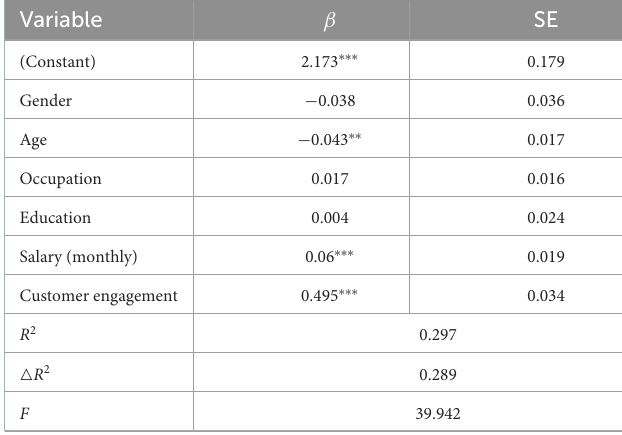
TABLE 7 Hierarchy regression results of control variables and customer engagement on brand